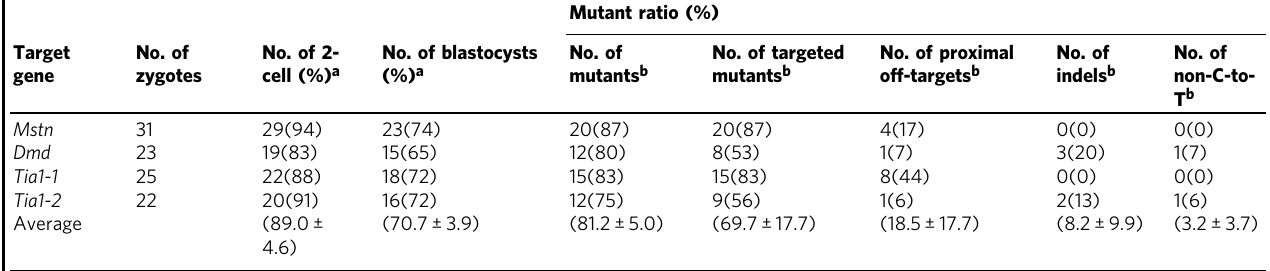
Table 1 Summary of embryo development and base editing rate using BE3 system